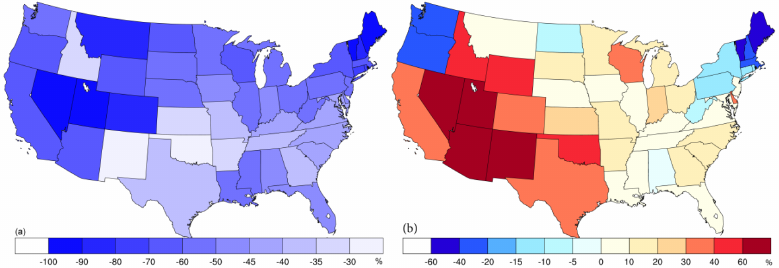
Figure 6. Relative mortality burden changes from 1990 to 2010 for the 48 states and the District of Columbia for PM 2 . 5 (a) and O 3 (b) . The relative changes are calculated as (2010–1990)/1990 × 100%. Note the different color scales for the two plots. The values for the District of Columbia are − 37% for PM 2 . 5 and − 23% for O 3 .